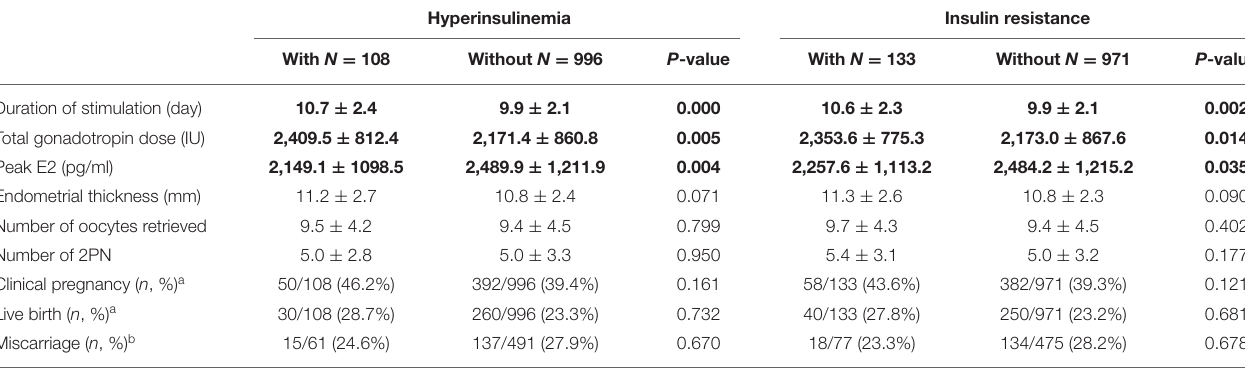
TABLE 4 | Ovarian stimulation outcomes of women with hyperinsulinemia and insulin